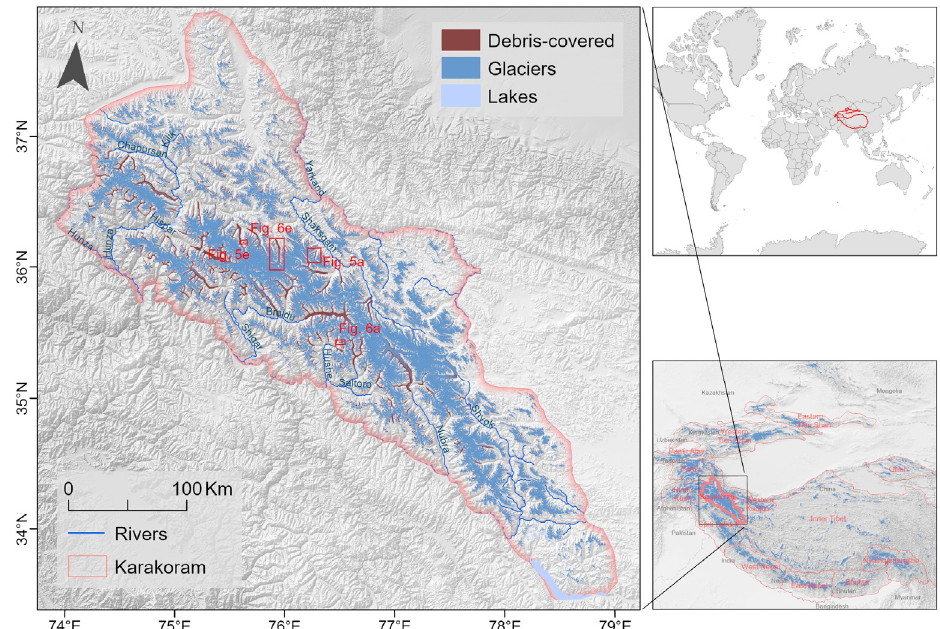
Figure 1. An overview of the Karakoram region. The inset in the lower left shows the location of the study area related to the glacier subregions in High ‐ Mountain Asia. study area related to the glacier subregions in High-Mountain